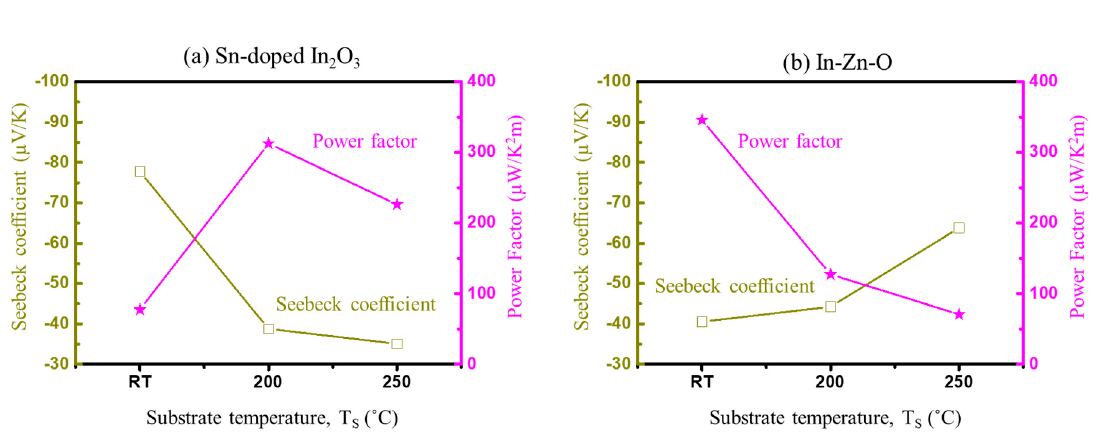
Figure 7. Seebeck coefficient ( □ ) and power factor ( ★ ) of the ( a ) c ‐ ITO and ( b ) a ‐ IZO films deposited at various substrate temperatures ( T S : RT, 200, and 250°C).